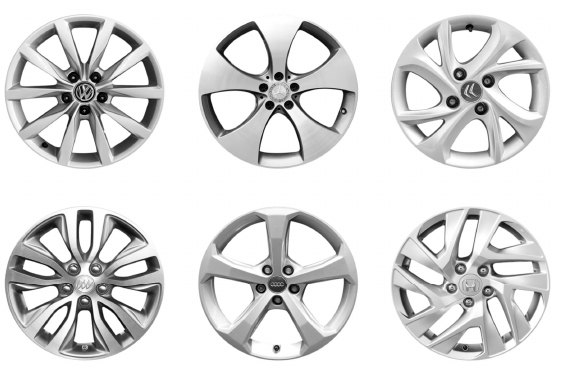
Figure 2. Research sample. A total of 682 wheels from 15 brands was used as the research samples, and all samples were pre-processed to avoid the influence of light and size on the results.